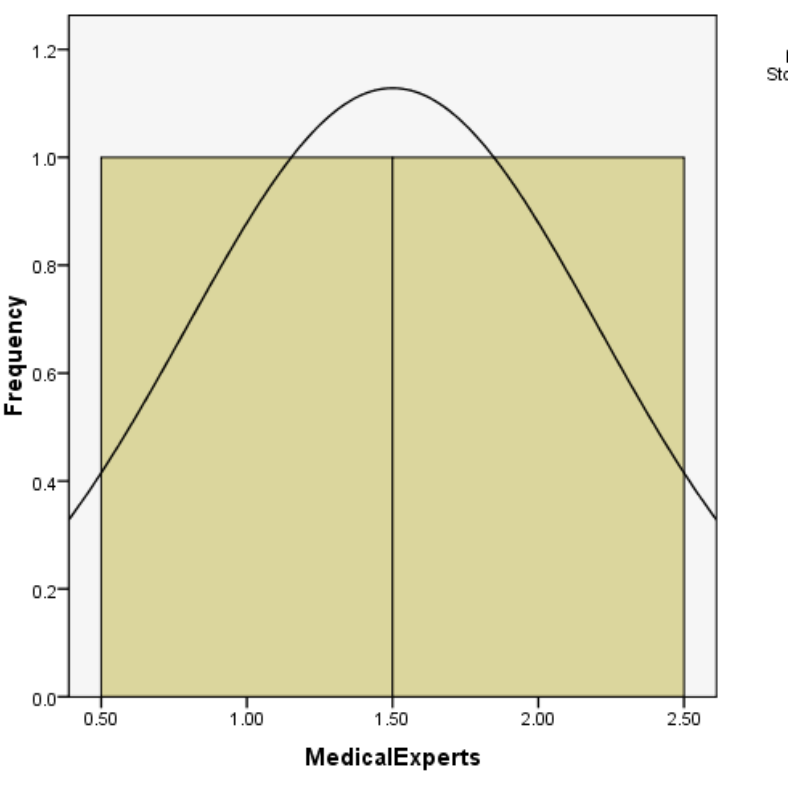
Figure 4. Medical Impact of